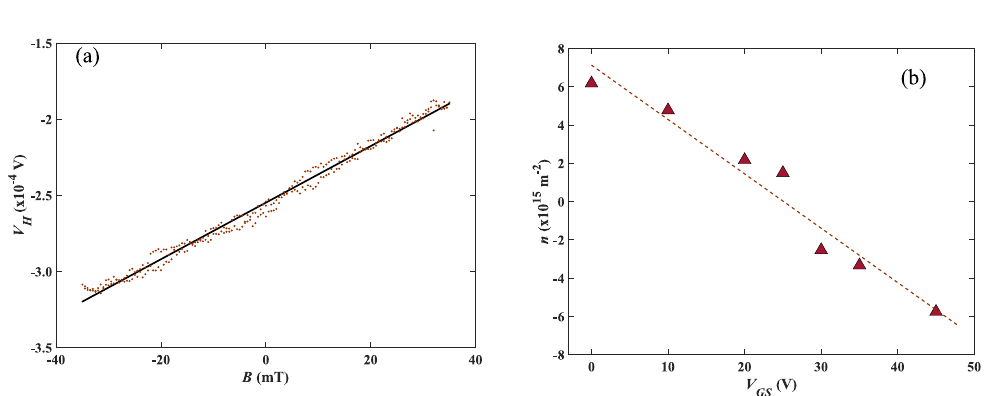
Figure 2. Resistance ( R DS ) versus back gate voltage ( V GS ) for a 1000 nm cross before and after the post-fabrication anneal, showing a pronounced downwards shift of the CNP.